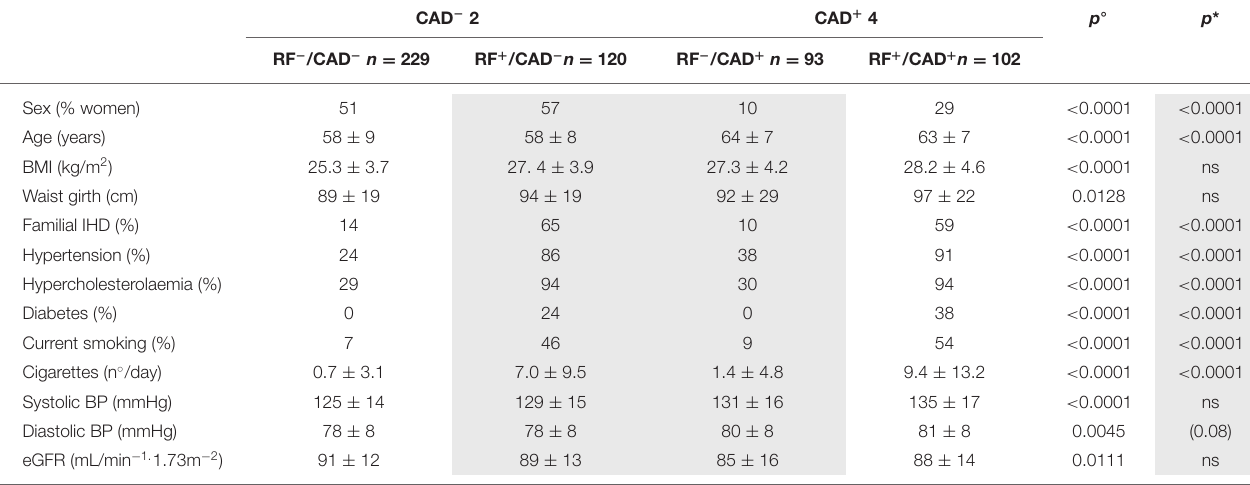
# Entries are mean ± SD; p ◦ , all groups; p * , outlier groups only (RF + /CAD- vs. RF-/CAD + ). BMI, body mass index; BP, blood pressure; CAD, coronary artery disease; eGFR, estimated glomerular filtration rate; IHD, ischaemic heart disease; ns, non significant; RF, risk factor. These CAD + and CAD − categories were further divided into those with low RF (RF − /CAD − and RF − /CAD + ) or high RF (RF + /CAD + and RF + /CAD − ) profiles ( Supplementary Figure 1 ). The RF + /CAD − (n = 120) and RF − /CAD + (n = 93) individuals were posited as the outlier groups. The shaded columns identify the outlier groups and the column reporting the p for their comparison.